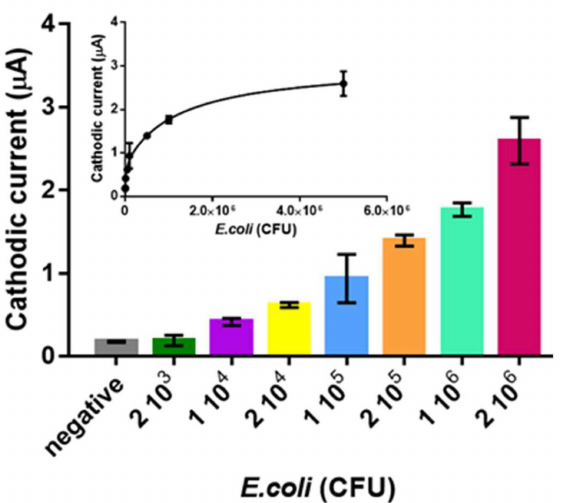
Figure 8. Rolling circle amplification and electrochemical genosensing of E. coli samples. The plots show the SWV maximal signal. The bars represent the mean value of the maximal signal and the error bars, the standard deviation for n = 3. All other conditions as Figure 6, including the negative controls are also shown (n =